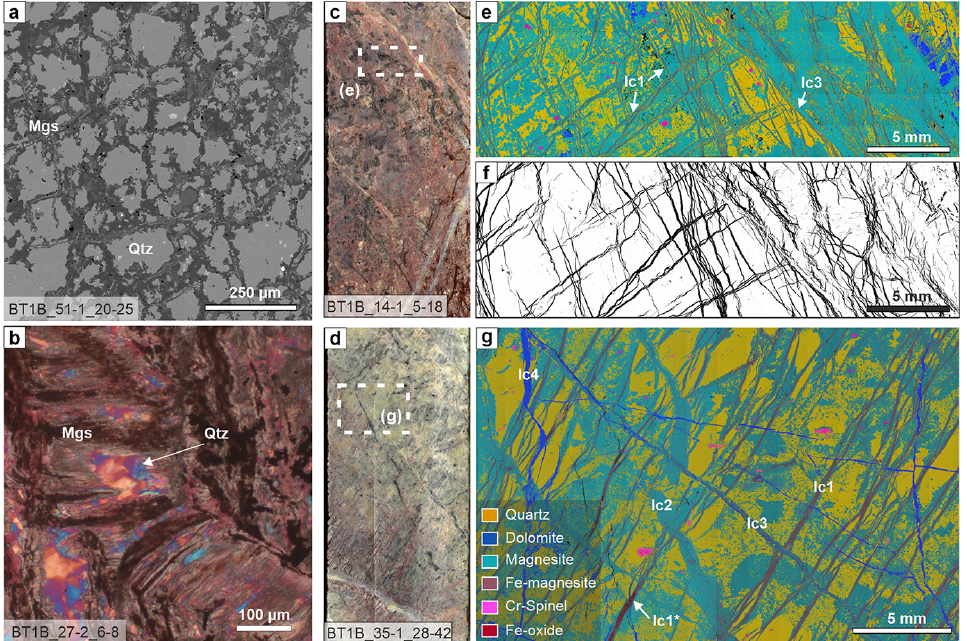
Figure 6. Veins in listvenite of Hole BT1B. (a) Magnesite pseudomorphic mesh vein network ( l ss0 , BSE image). (b) Pseudomorphic magnesite–quartz after a serpentine crack–seal vein ( l ss2 , xpol with 1 λ plate). (c) Split-core image of listvenite with a conjugate cross- cutting and locally anastomosing zoned magnesite vein network. (d) Split-core image of listvenite with parallel carbonate veins that are locally oxidized. (e) Composite-color EDX map of the indicated area in (c) , showing different magnesite vein generations and a patchy quartz distribution in the matrix (common legend in g ). (f) Same area as in (e) , segmented for Fe magnesite (15.8%). (g) Composite-color EDX maps of the area in (d) showing cross-cutting relationships between different carbonate vein generations (see Table 1). Dark red veins (lc1 ∗ ) contain abundant Fe oxides (red veins in d ). Core diameter in (a) and (d) is